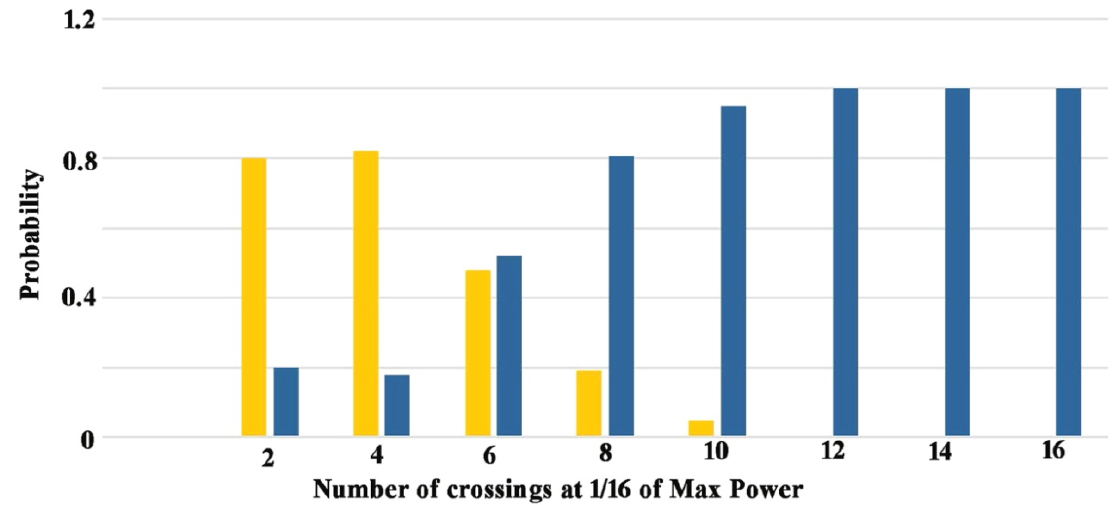
Figure 7. Probability for sand (yellow) or sandstone (blue) for a given number of crossings at 1/16 of the maximal normalized power.